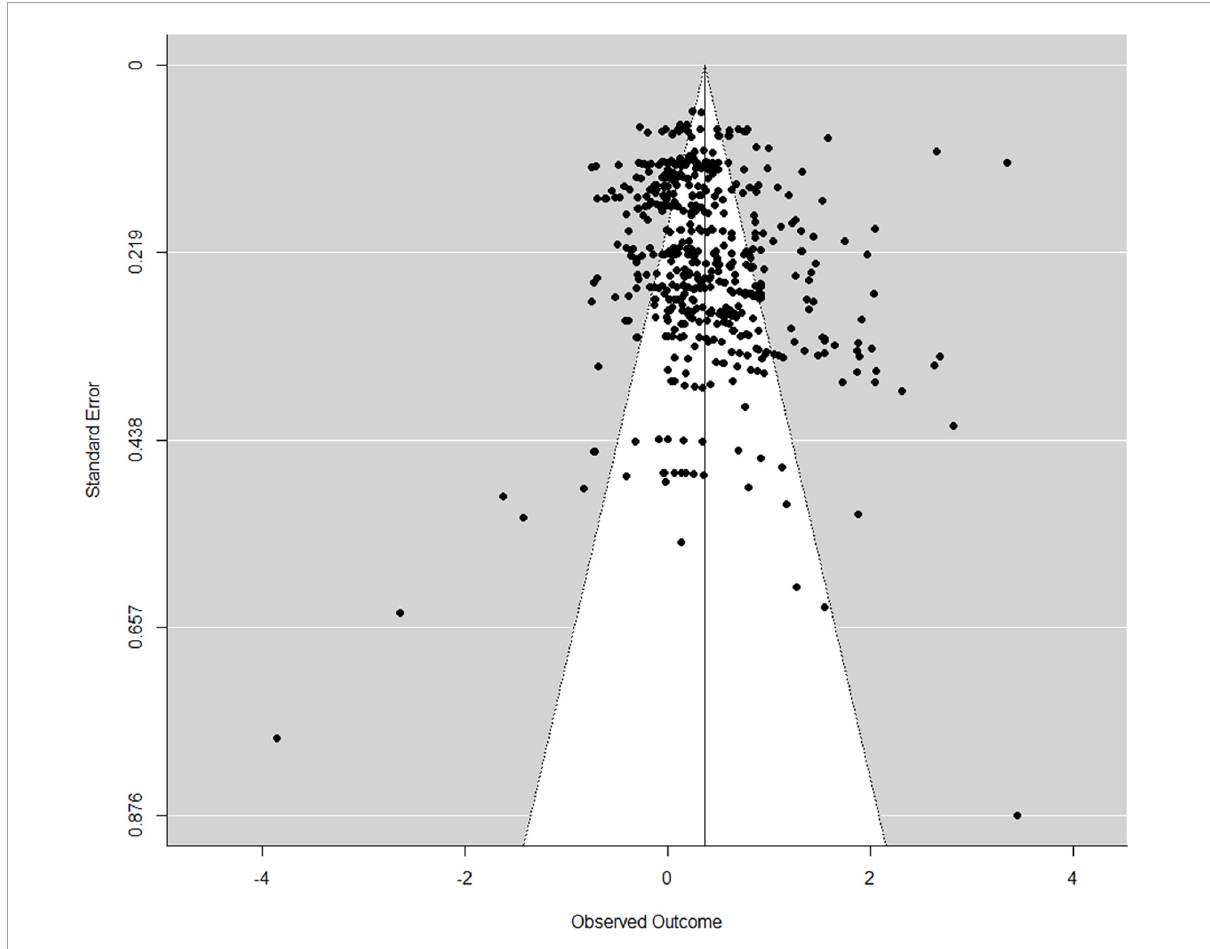
FIGURE2 Funnel plot with pseudo 95% confidence